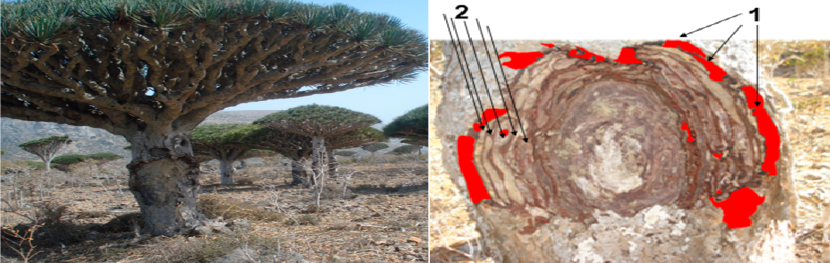
Figure 5. Wounds on the tree and demonstration show harvested wound, present season (red color) ( 1 ) and area harvested in previous seasons ( 2 ). Own